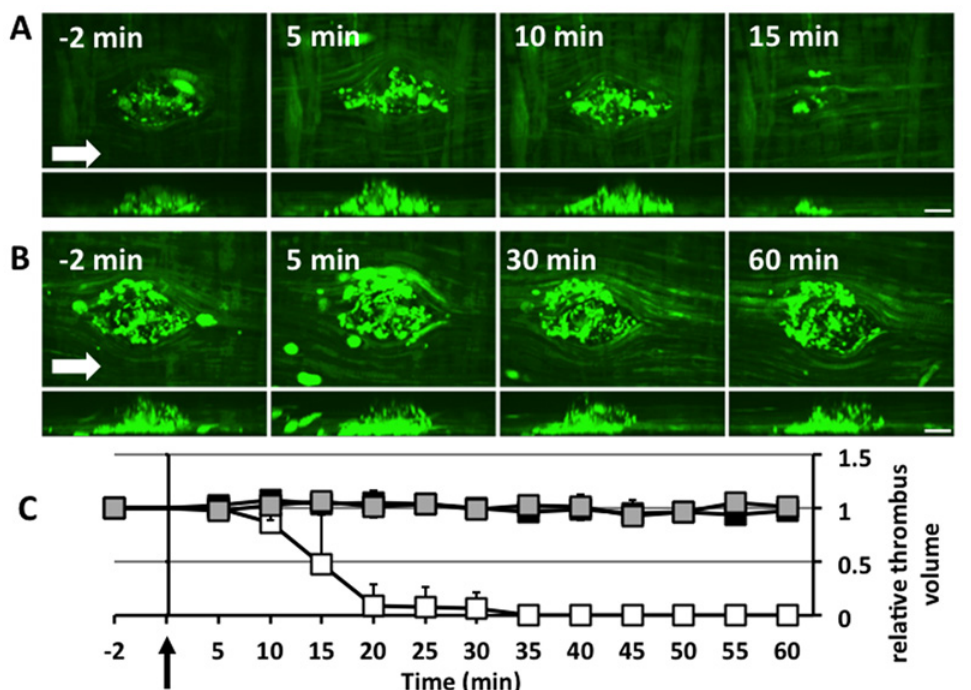
Fig 6. tPA-induced lysis of microthrombi. (A) tPA was injected at a dose of 3 mg/kg 40 minutes after the laser-induced injury. Images were captured 2 minutes before and every 5 minutes up to one hour after tPA administration. (B) In another set of experiments, EACA (4.25 mmol/kg) was administered intravenously through the femoral vein of GFP-mice 10 minutes before the laser injury, and images were captured in a similar manner. In both Figures (A) and (B), the upper panel shows horizontal plane (X-Y) images and the lower panel shows perpendicular plane (Y-Z) images, which were reconstructed from sequential optical sections of microthrombi. Arrows show the direction of blood flow. The scale bars represent 10 μ m. (C) Relative changes in the volumes of thrombi after tPA administration. tPA or saline was injected at time 0 (arrow). Volumes of thrombi were normalized to their values 2 minutes before saline or tPA injection. Thrombi in mice treated with saline did not change in size (gray squares), whereas all of the thrombi in mice treated with tPA 40 minutes after the laser injury dissolved completely within 35 minutes after tPA administration (white squares). When mice were pretreated with EACA 10 minutes before the laser injury, however, tPA-dependent thrombolysis was totally inhibited (black squares). Each point represents the mean value of 5 thrombi from 5 mice ± SD.